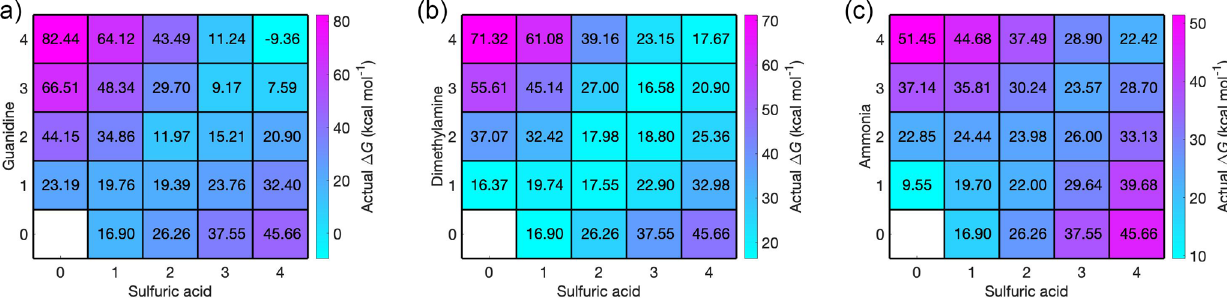
Figure 2. Vapor concentration-dependent Gibbs free energies for electrically neutral acid–base clusters at 298.15K. Sulfuric acid concen- tration is 10 7 cm − 3 in all cases, and for bases the relative concentrations of [guanidine] = 10 − 5 ppt V (a) , [dimethylamine] = 1ppt V (b) and [ammonia] = 10 5 ppt V (c) are